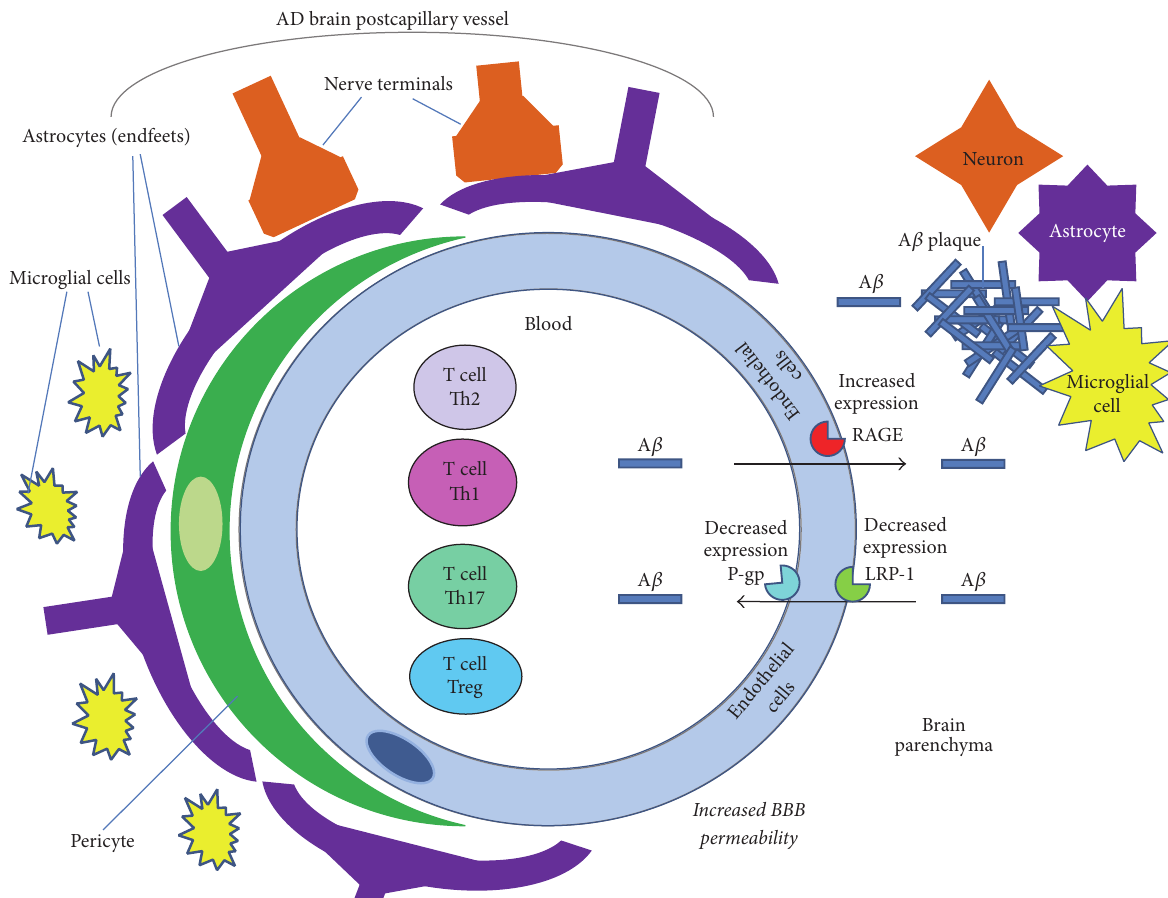
Figure 1: A 𝛽 transport across the blood brain barrier (BBB) in Alzheimer disease. In Alzheimer disease the loosing of tight junctions leads to increased BBB permeability. In healthy conditions the A 𝛽 peptide is transported to the brain by the receptor for advanced glycosylation products(RAGE)andclearedfromthebraintothebloodbyLDL-Receptor-Proteins(LRPs)followedbyp-glycoprotein(P-gp).InAlzheimer’s disease these transport systems are impaired: the expression of RAGE is increased and the expression of LRPs is decreased, leading to the accumulation of A 𝛽 in the